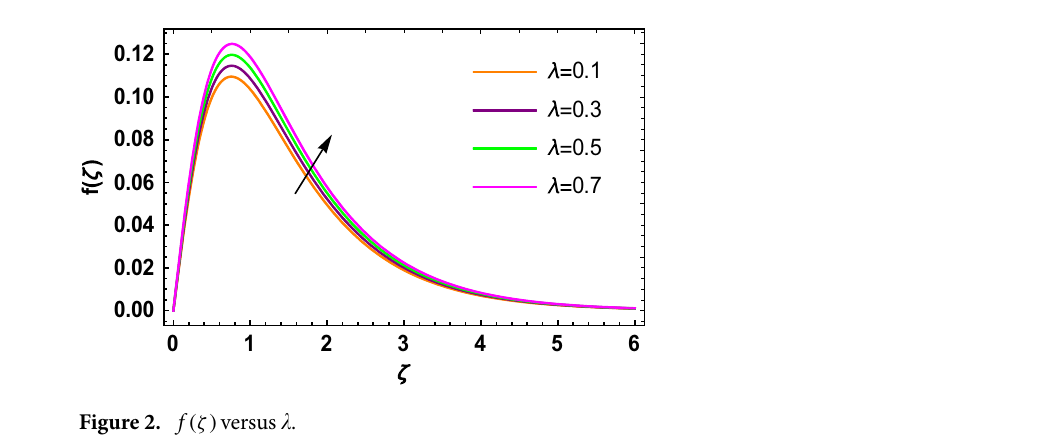
Figure 2. f (ζ) versus (cid:31)